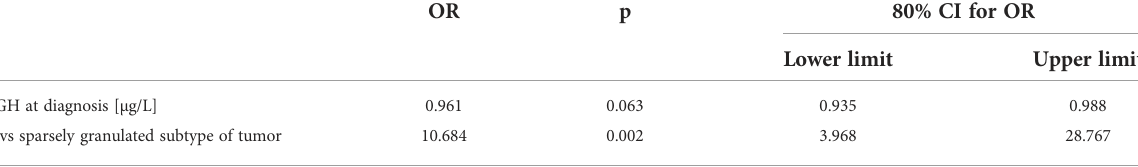
percentage of correctly classi fi ed patients was 74.5% (Table 5;